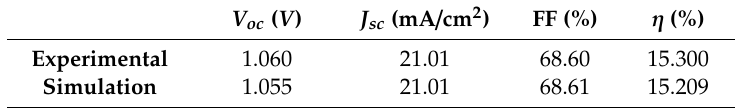
Figure 7. J–V curves of experimental and simulated solar cell. Table 2. Comparison of electric parameters between experimental and simulated cells.